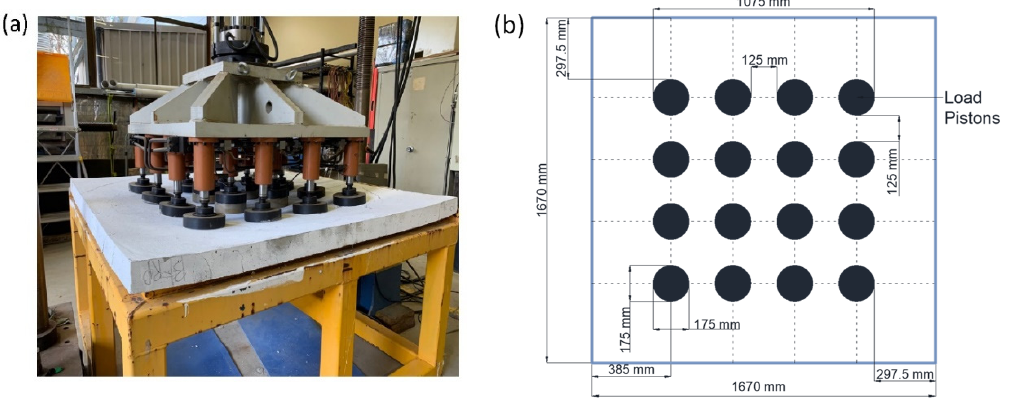
Figure 4. ( a ) Photo of the UDL application on the concrete slab; ( b ) schematic diagram of the loading points on a slab.